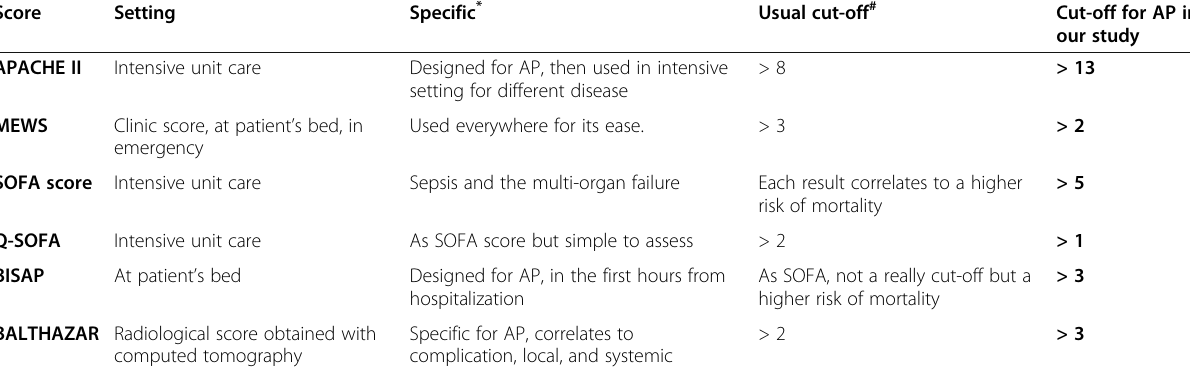
Table 6 A brief introduction to